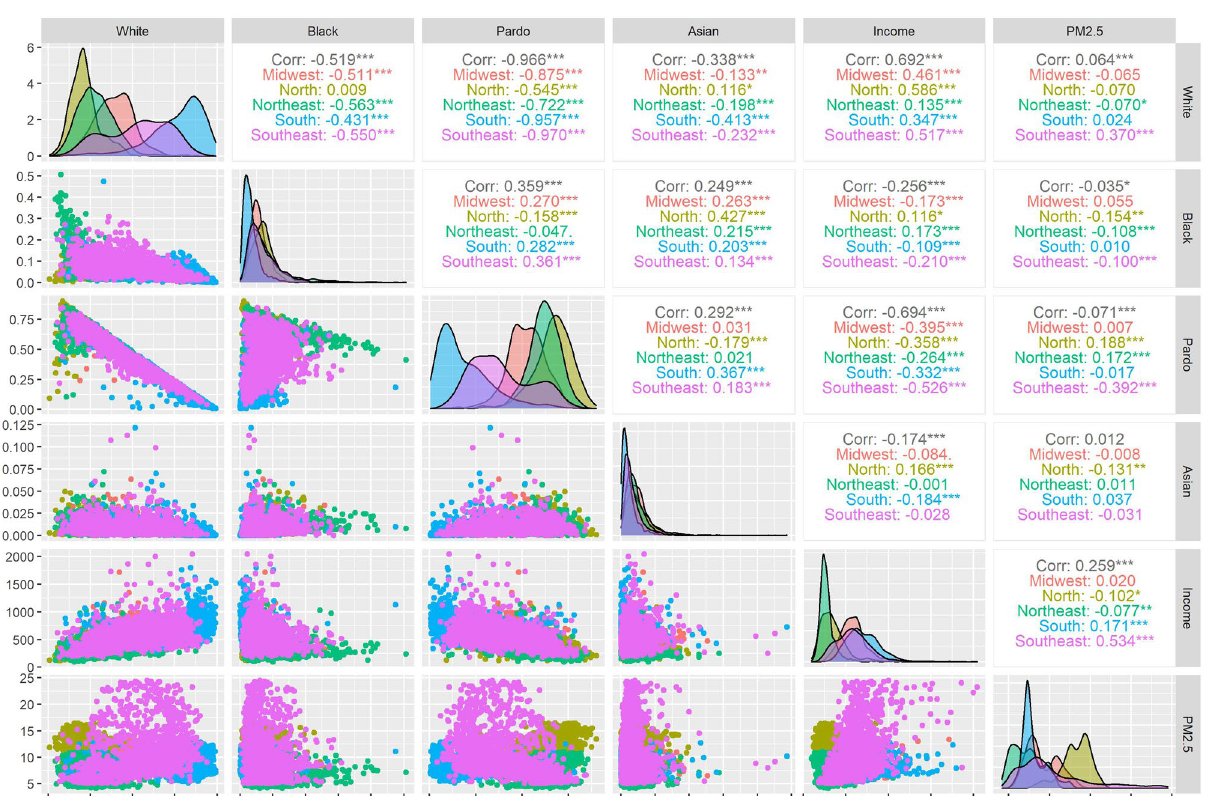
Figure 3. Correlation matrix, density plots, and scatter plots for PM 2.5 , population by race groups, and income stratified by regions. Note : *indicates the significance level for the Spearman coefficients; “Corr” is the correlation at national